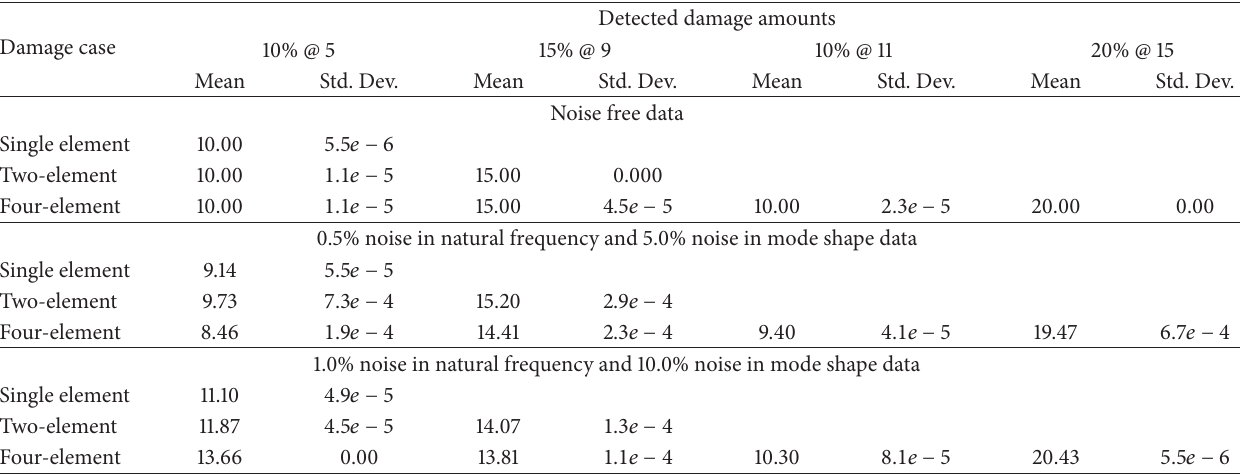
Table 3: Statistical results for damage identification in cantilever beam.